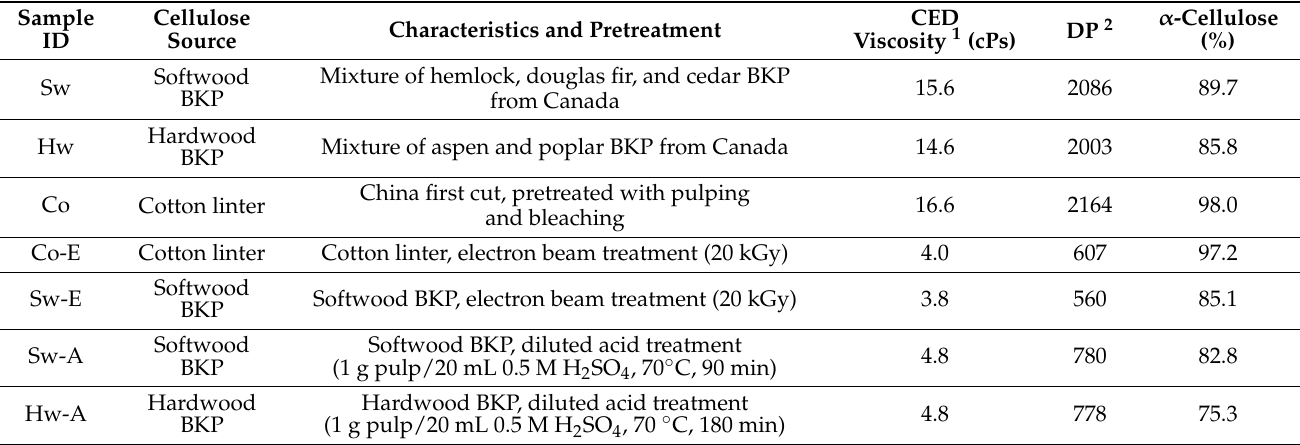
Table 1. Characteristics of cellulose resources.